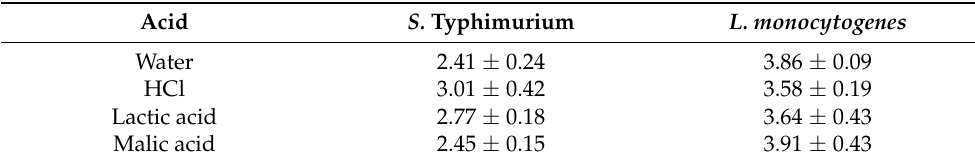
Table 4. S. Typhimurium and L. monocytogenes reduction (log CFU) by water, HCl, lactic acid and malic acid on whole papayas *.